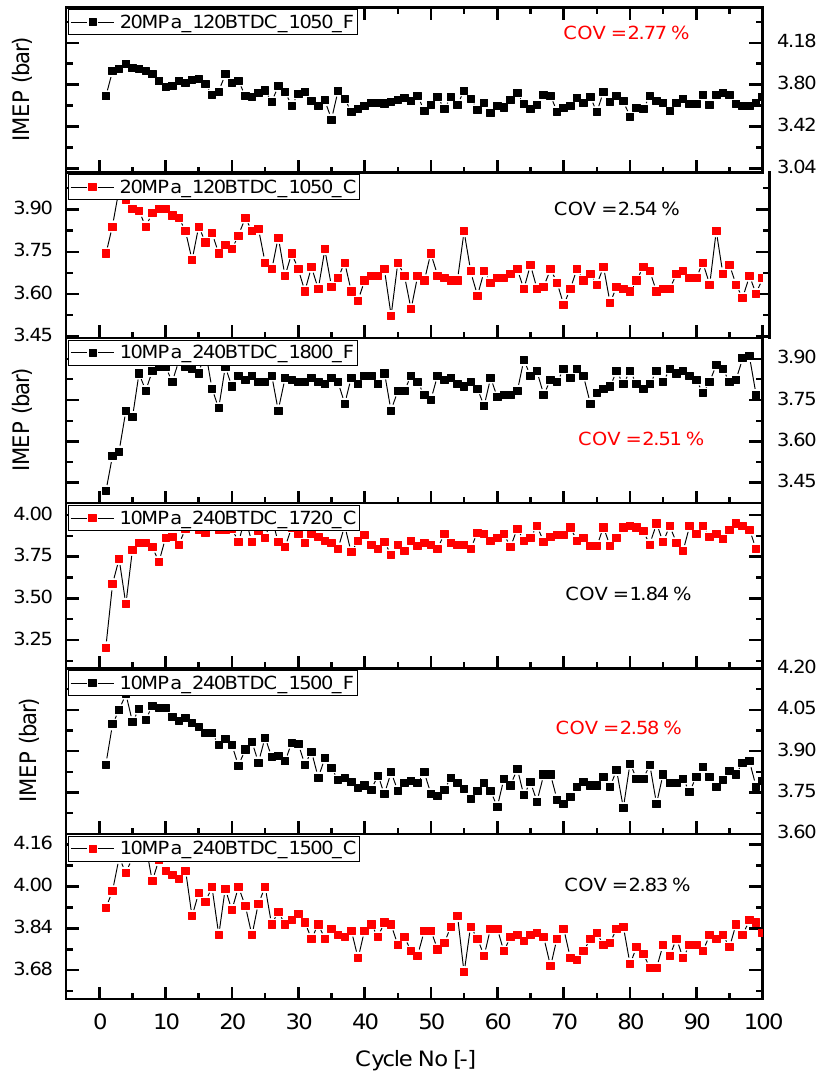
Figure 4. IMEP of over 100 engine cycles under various injection strategies.